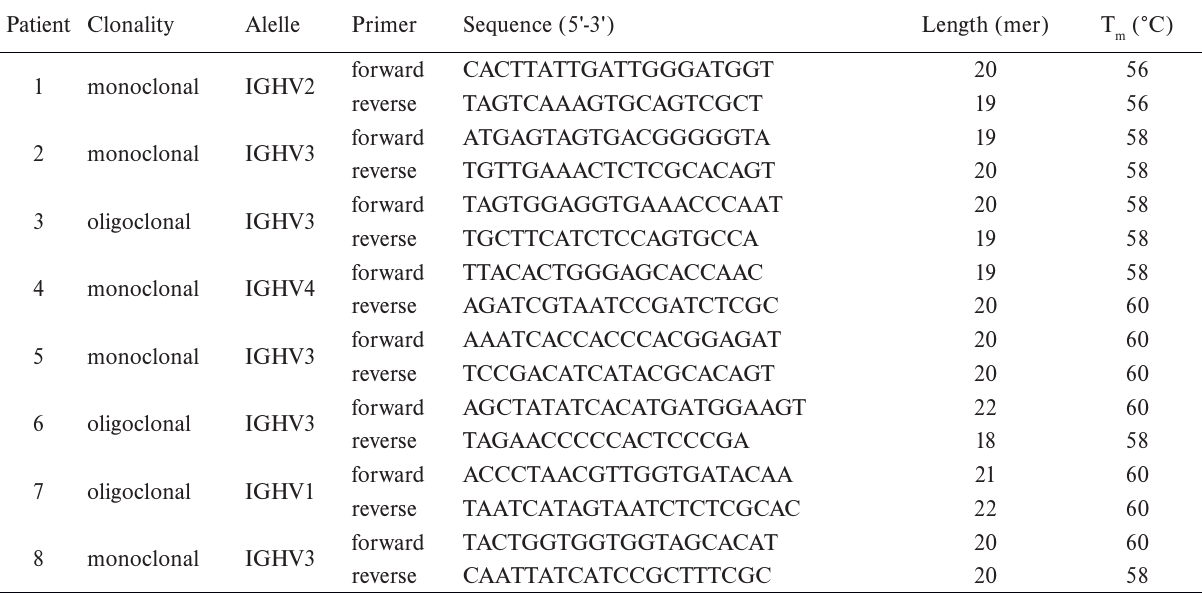
Table S1. Characteristics of used designed ASO primers for qualitative PCR detection of tumor-specific marker in MM.